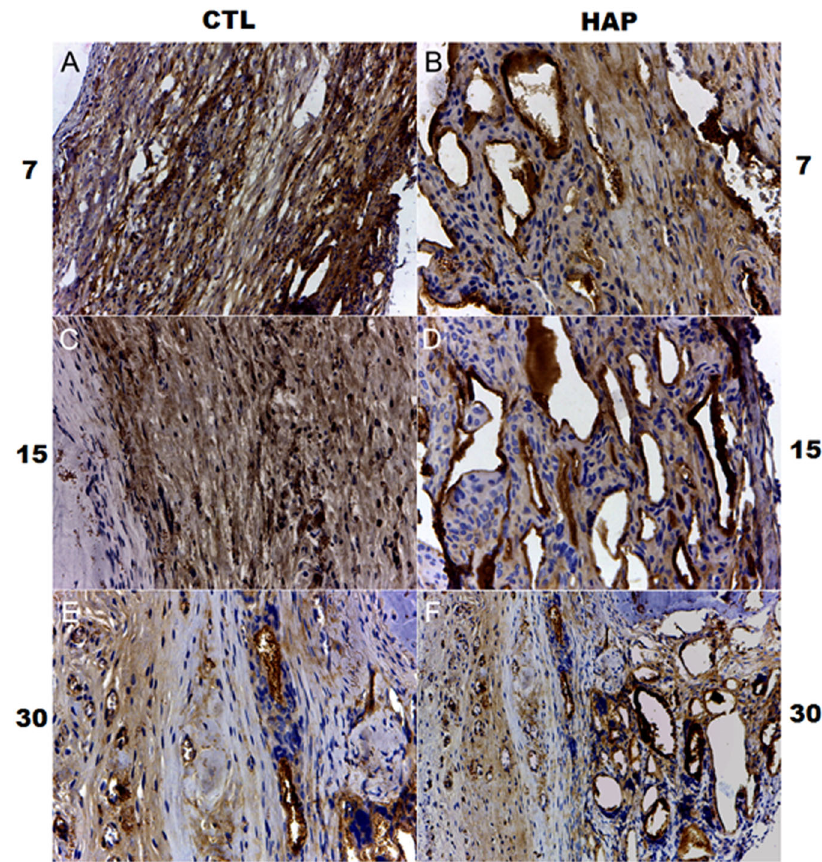
Fig. 6 Immunohistochemistry of RUNX-2 in rat calvaria following HAP implantation after 7, 15 and 30 days post- implantation: CTRL control group, HAP hydroxyapatite group. ABC. stain. ×40 magni fi